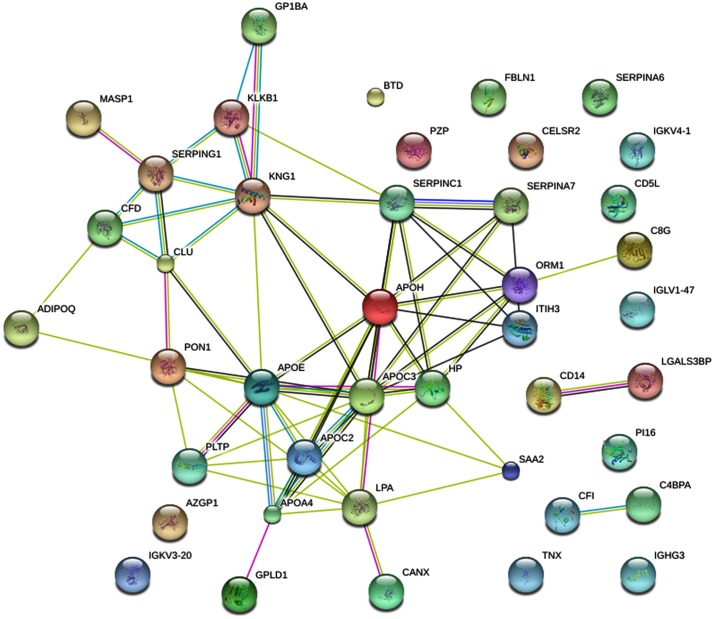
Protein-protein interactions among differentially expressed proteins predicted by ‘String’. The interactions include direct (physical) and indirect (functional) associations and are derived from four sources: genomic context, high-throughput experiments, (conserved) coexpression, and previous knowledge. GPLD1 associates with the most intense protein interaction network group.